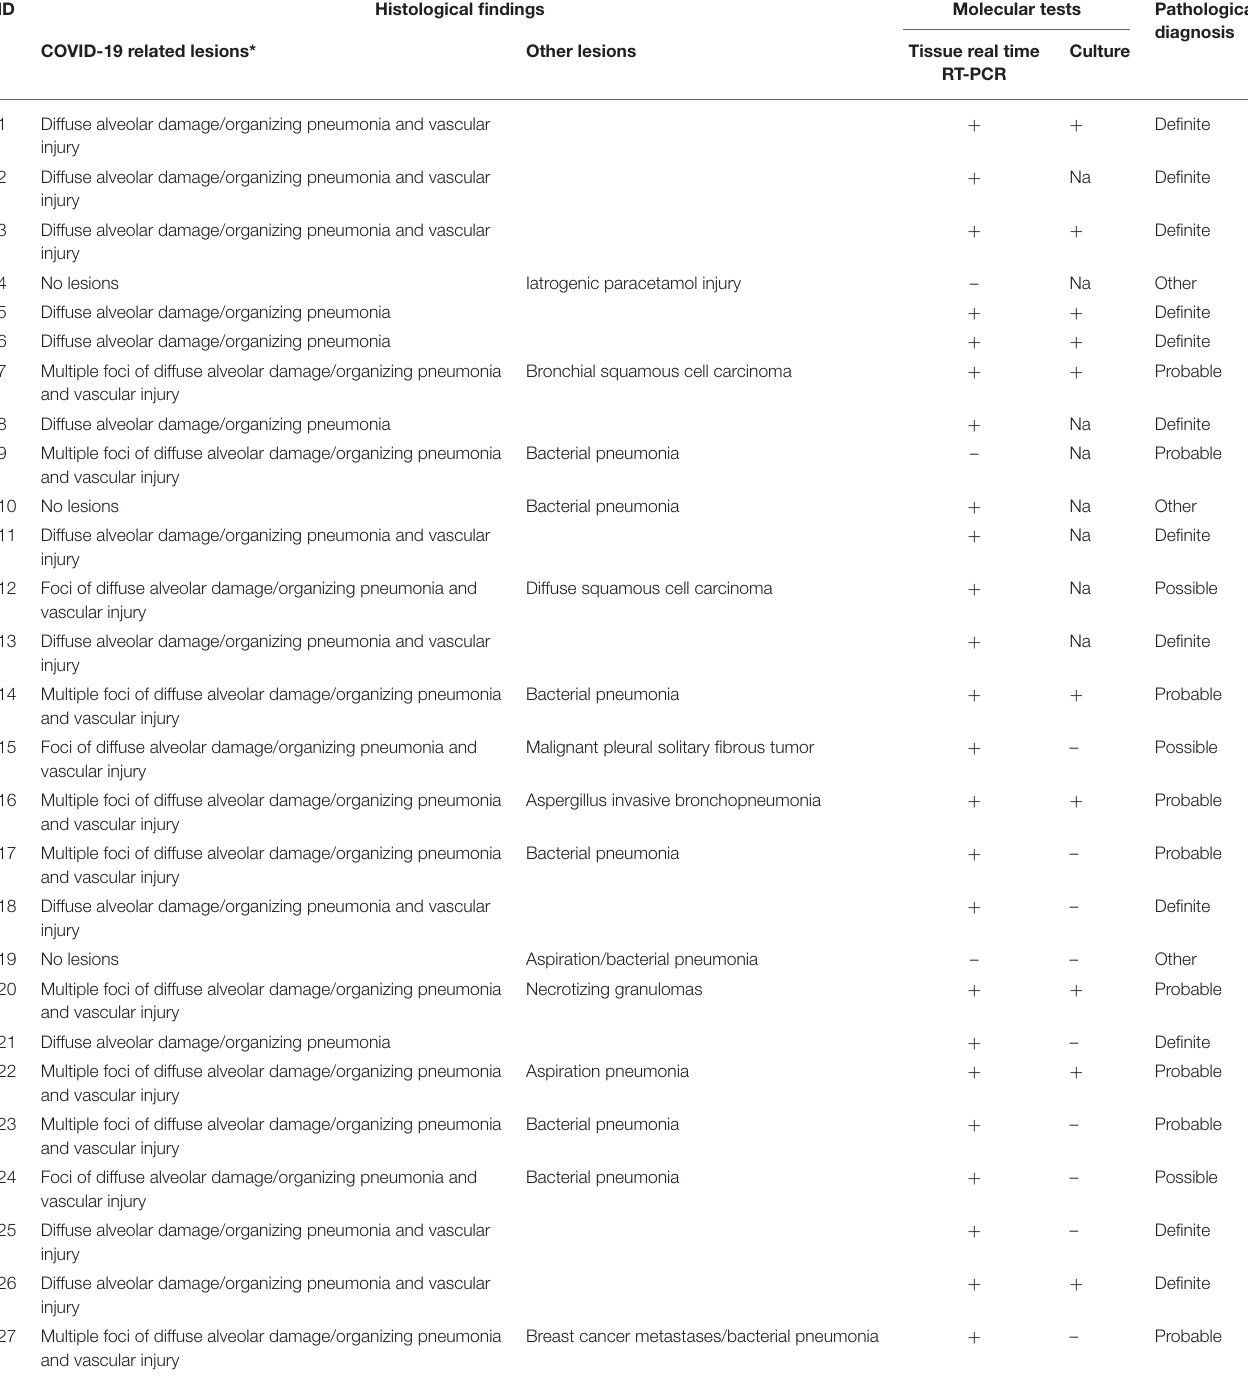
TABLE 3 | Results of lung histological examination, molecular tissue and cultural analyses.